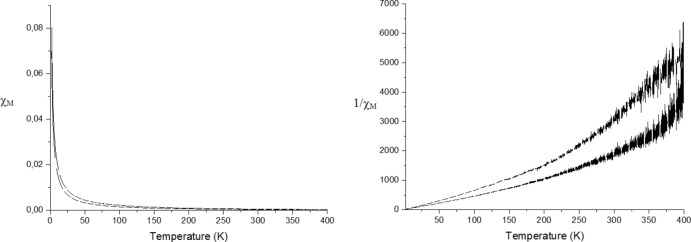
Temperature dependence of molar magnetic susceptibility χM and inverse susceptibility 1/χM.